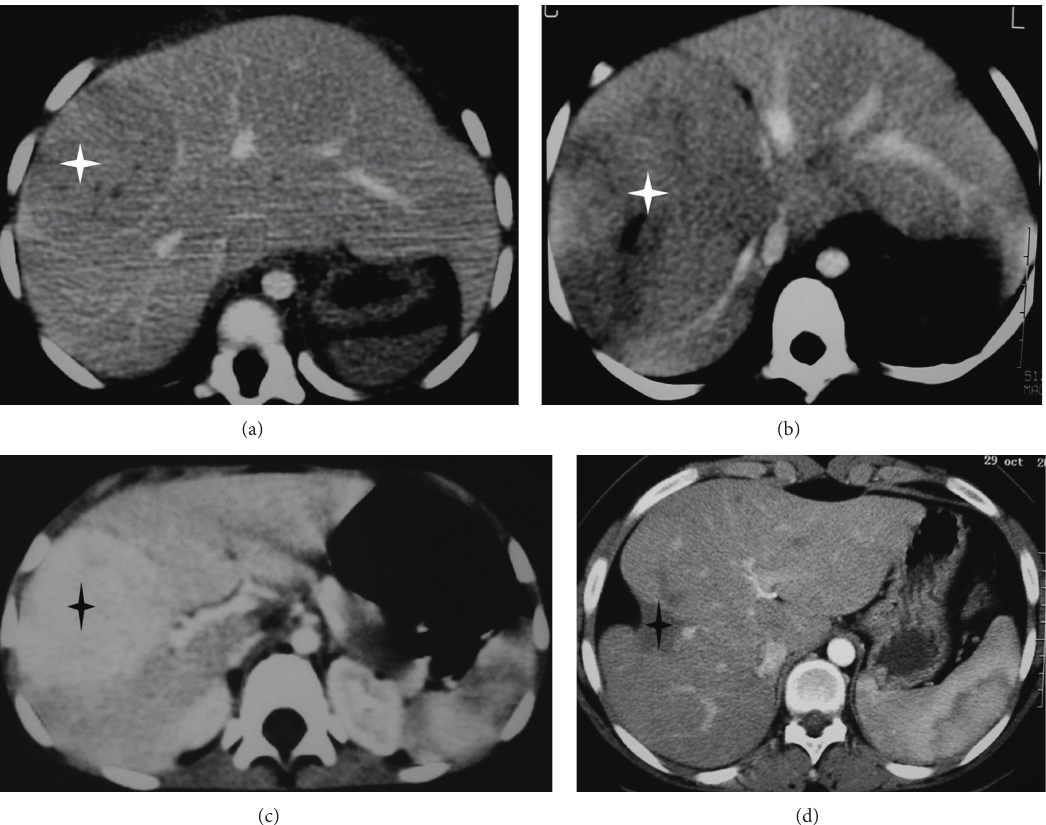
Figure 3: Spontaneous evolution of fortuitously discovered FNH in two children. (a) and (b): three-year-old girl with sickle-cell disease. CT scan after contrast injection at the portal phase at diagnosis (a). And three years later (b) shows growth of the tumor from 5 to 12cm diameter. (c) and (d): eight-year-old girl. CT scan after contrast injection at diagnosis (c) and 12 years later (d) shows the spontaneous disappearance of the 5cm diameter tumor with capsular